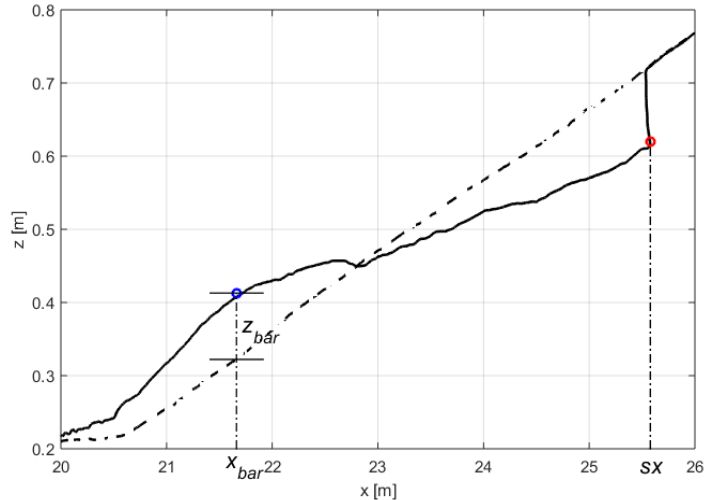
Figure 3. Dimension indicators of the scarp and the breaker bar (dashed line indicates the initial profile, and solid line shows a typical final profile).